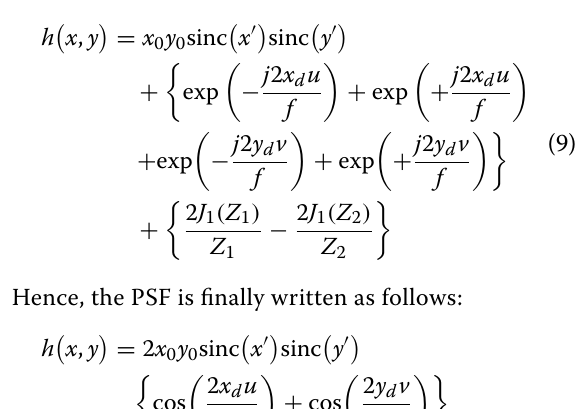
Fig. 1 a An aperture composed of four squares arranged symmetrically along the cartesian coordinates and obstructed by a circular annulus placed in the center of diameter 128 pixels and annular width 16 pixels. Each square has dimensions 128 128 pixels × compared with the whole matrix of dimensions 1024 1024 pixels. × b An aperture composed of four squares arranged symmetrically along the cartesian coordinates and obstructed by a square annulus placed in the center of width 16 pixels. Each square has dimensions 128 128 pixels and shifted by 256 pixels along the coordinates. × c An aperture composed of two squares arranged symmetrically along the y‑axis, and two rectangles arranged along x‑axis and obstructed by an annular rectangle placed in the center. Each square has dimensions 128 128 pixels and shifted by 256 pixels along the × coordinates, and each rectangle has dimensions 128 512 pixels and × shifted by 256 pixels from the x‑axis. d An aperture composed of a ± square of dimensions 640 640 ×